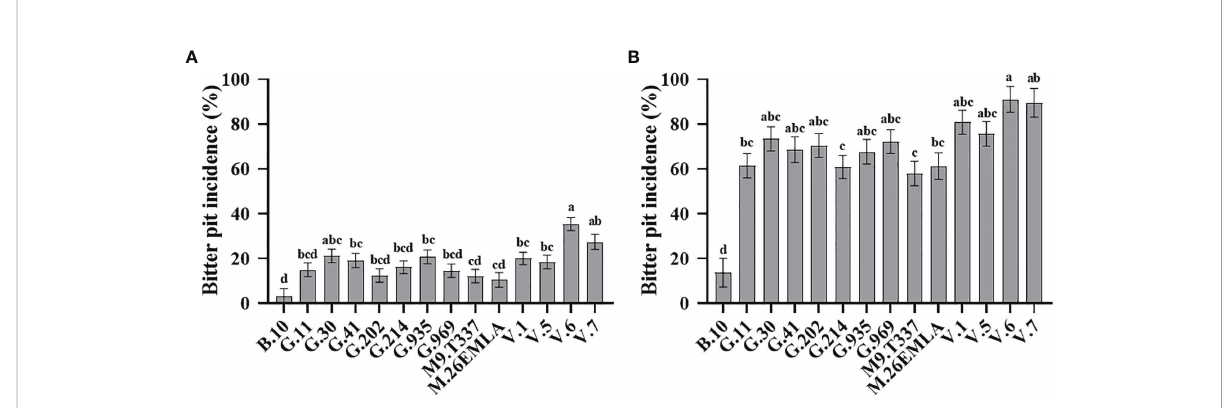
FIGURE 1 Rootstock effects on bitter pit (BP) incidence in ‘ Honeycrisp ’ apples. (A) Cumulative BP incidence at harvest (each bar represents the average of four growing seasons); (B) cumulative BP incidence after three months of cold storage (each bar represents the average of three growing seasons). Means not sharing any letter are signi fi cantly different at a = 0.05., according to Tukey ’ s HSD test in JMP Pro